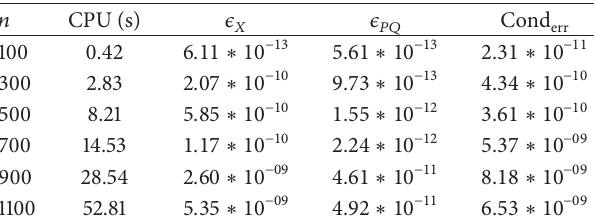
Table 2: Variant matrix sizes 𝑛 for solutions to (2) with 𝑃𝑋 = 𝑋𝑄